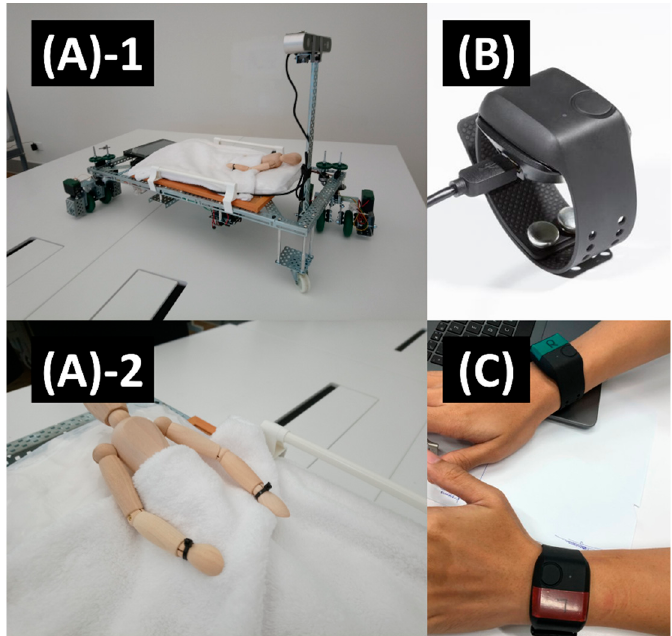
Table 4. Empatica E4 wristband sensor breakdown.